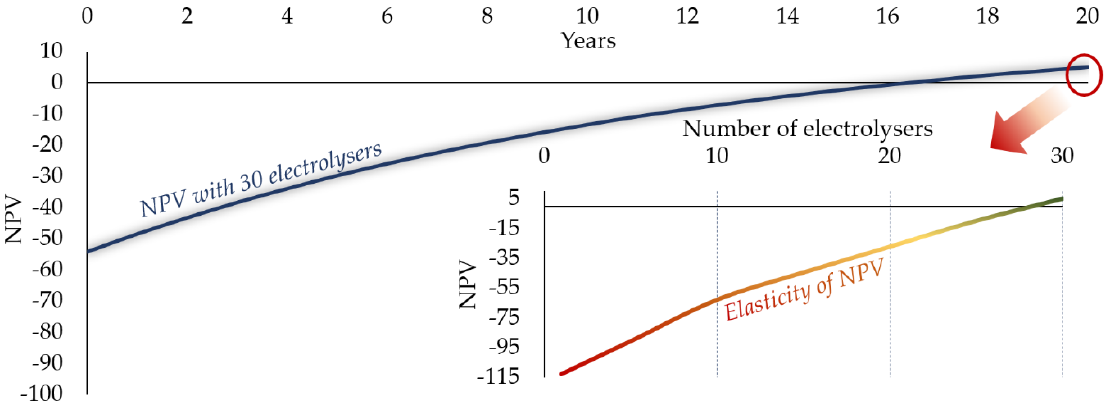
Figure 9. Net Present Value (NPV) of the electrolysis plant, RUB billion.